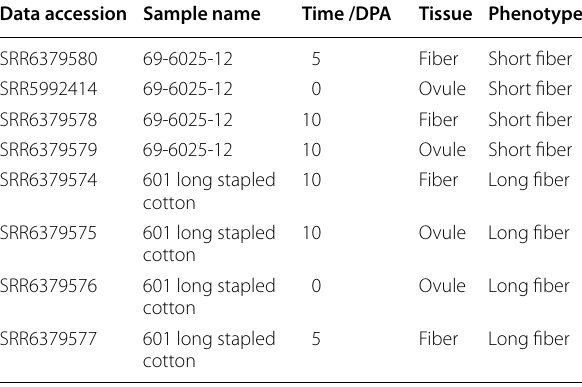
The basic information about transcriptome dataset, including data accession, sample name, tissue, time of tissue and phenotype was recorded